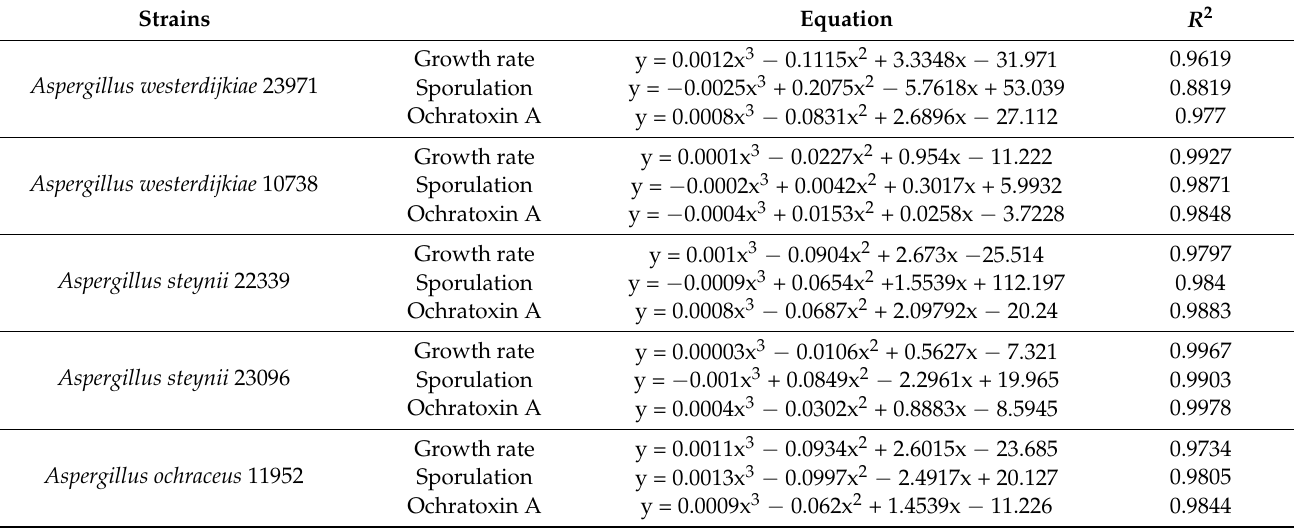
Table 2. Predictive model equations based on third-order polynomial regression.